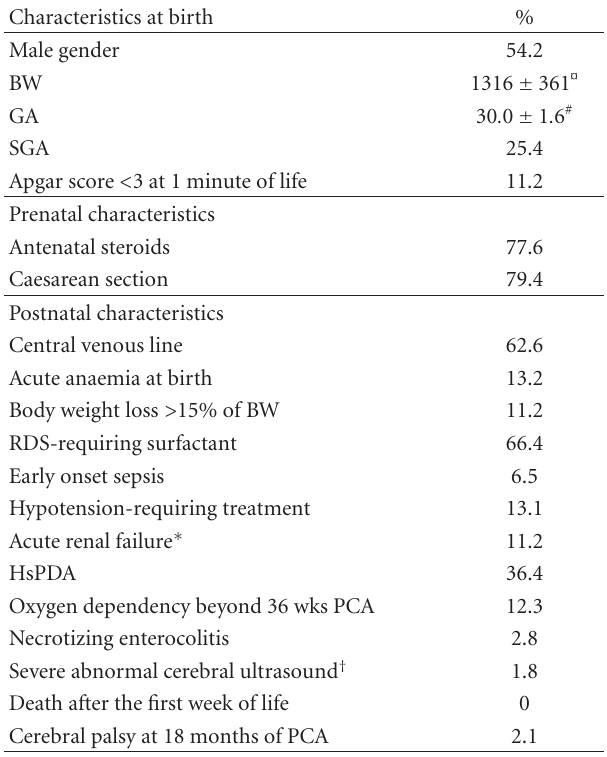
Table 1: Characteristics of 107 infants < 33 weeks of GA hospital- ized in